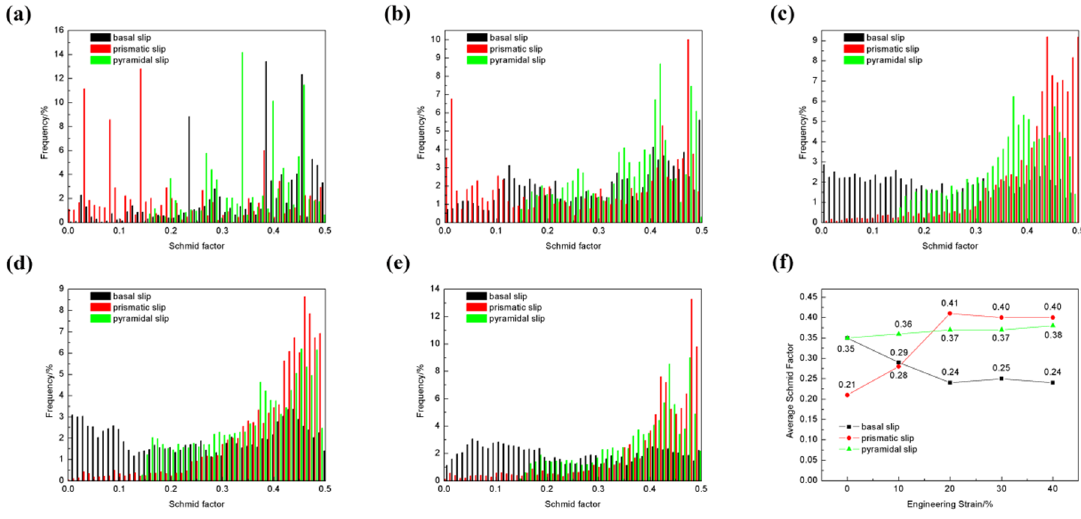
Figure 9. Schmid factor (SF) distribution maps of as-extruded 0.05 wt.% ND / ZK60 composite under varied strains at the deformation temperature of 200 °C and strain rate of 1 s −1 : ( a ) 0, ( b ) 10%, ( c ) 20%, ( d ) 30%, and ( e ) 40%, ( f ) the average Schmid factor with different engineering strain.